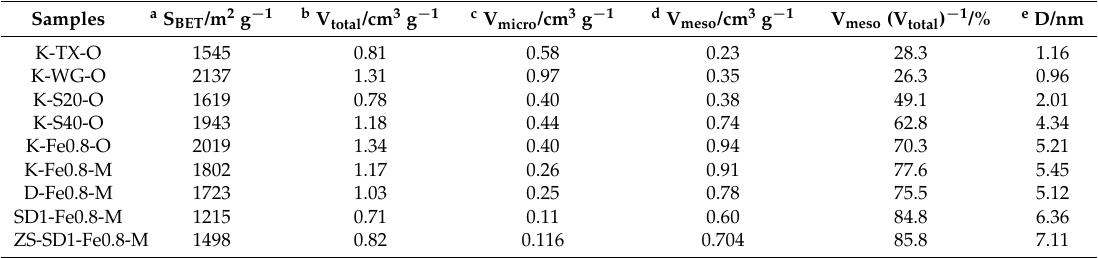
Table 1. Structure parameters of the prepared catalyst samples based on N 2 adsorption/desorption. Samples a S BET /m 2 g −